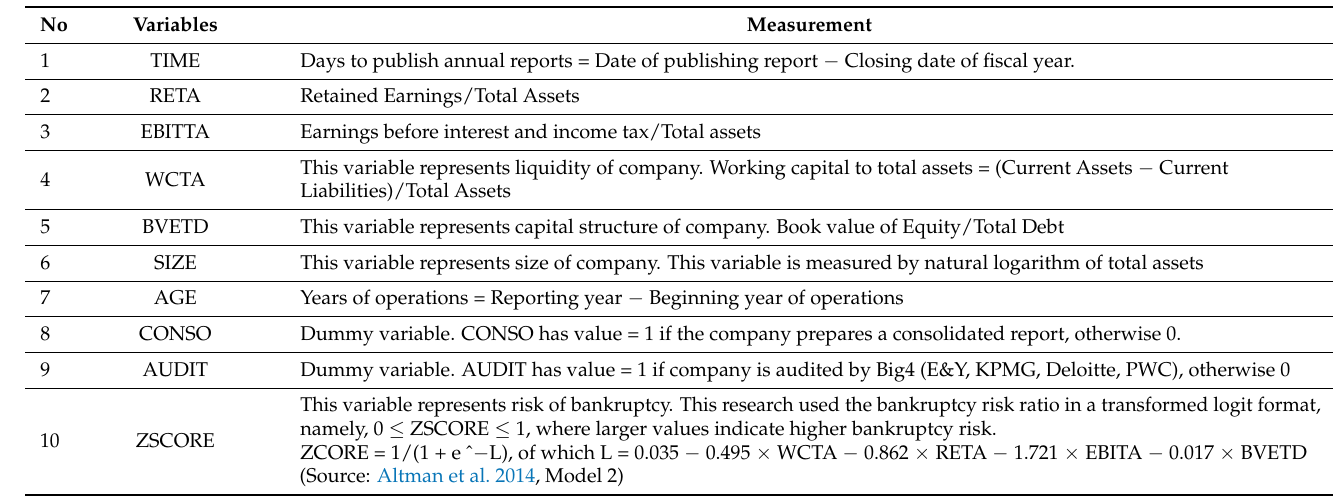
Table 1. Measurement of variables used in research models.